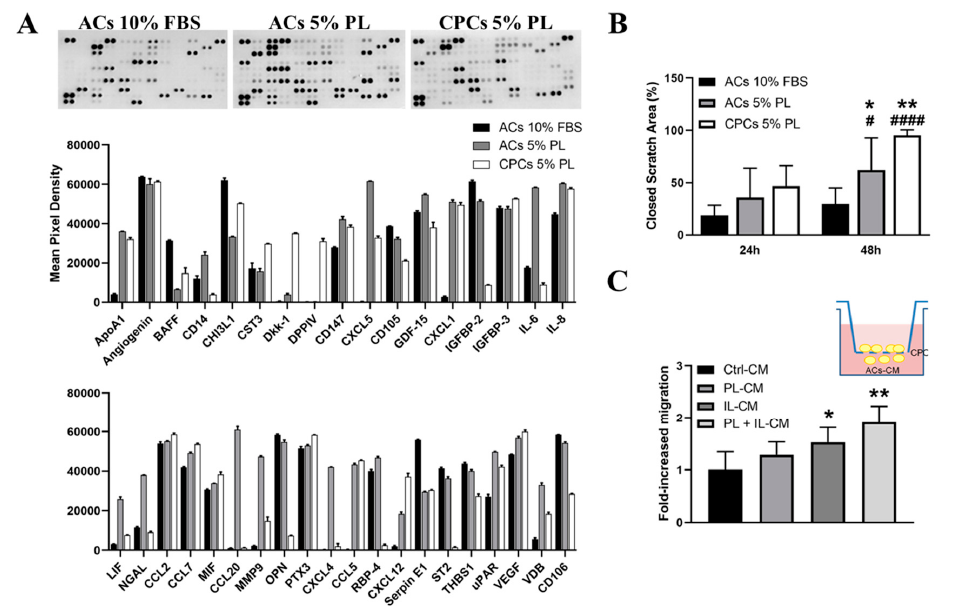
Figure 7. In vitro analysis of ACs and CPCs secretory profiles, migratory capability and CPC chemotaxis in an osteoarthritis (OA) mimetic system. ( A ) Quantification of the mean pixel density for each identified cytokine in the three experimental groups. Error bars represent the uncertainty in measurement; pictures on the top shows the cytokine array membranes of CM of ACs—10% FBS, ACs—5% PL and CPCs—5% PL, from left to right. ( B ) “Closed scratch area (%)” calculated by TScratch software at each time points in all three experimental groups. Data are represented as mean ± SD ( N = 3, * p < 0.05 and ** p < 0.01 versus ACs-FBS or ACs-PL at the same time point; # p < 0.05 and #### p < 0.0001 versus 24 h in the same experimental group by Kruskal-Wallis with Dunn’s multiple comparison test). ( C ) Quantification of CPC migration in the presence of ACs-CM obtained in four di ff erent conditions: control (CTRL-CM, 10% FBS culture), PL-treatment (PL-CM, 5% PL culture), inflammatory stimulus (IL1-CM, IL1- β culture) and PL-treatment plus inflammatory stimulus (PL + IL1-CM, 5% PL plus IL1- β culture). Data (mean ± SD) are reported as fold-increased migration as compared to control, set to 1 value ( N = 3, * p < 0.05 and ** p < 0.01 versus CTRL-CM by one-way ANOVA